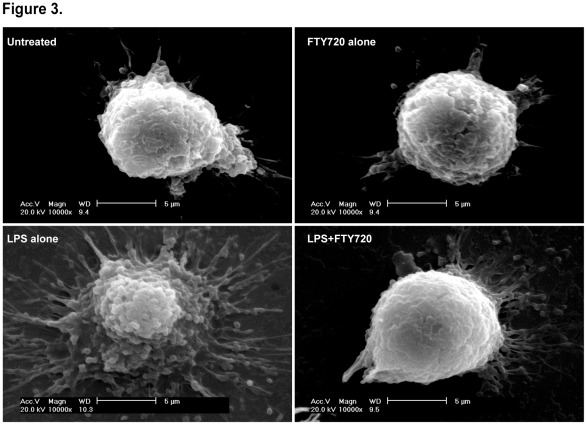
Scanning electron microscopic observation.Day 6 BMDCs were treated with LPS (1 µg/mL) and/or FTY720 (500 nM) for additional 48 h before SEM observation. Scale bar = 5 µm.